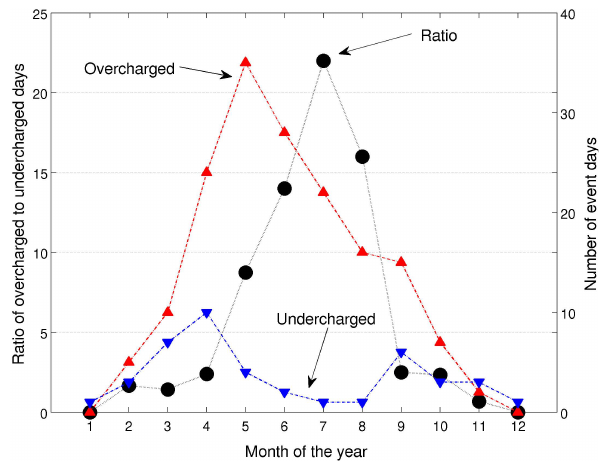
Fig. 1. Ratio of overcharged events to undercharged events for each month over the 2005–2007 period (black circles, left vertical axis). The number of event days is also presented for overcharged days (in red) and undercharged days (in blue), and report to the right vertical